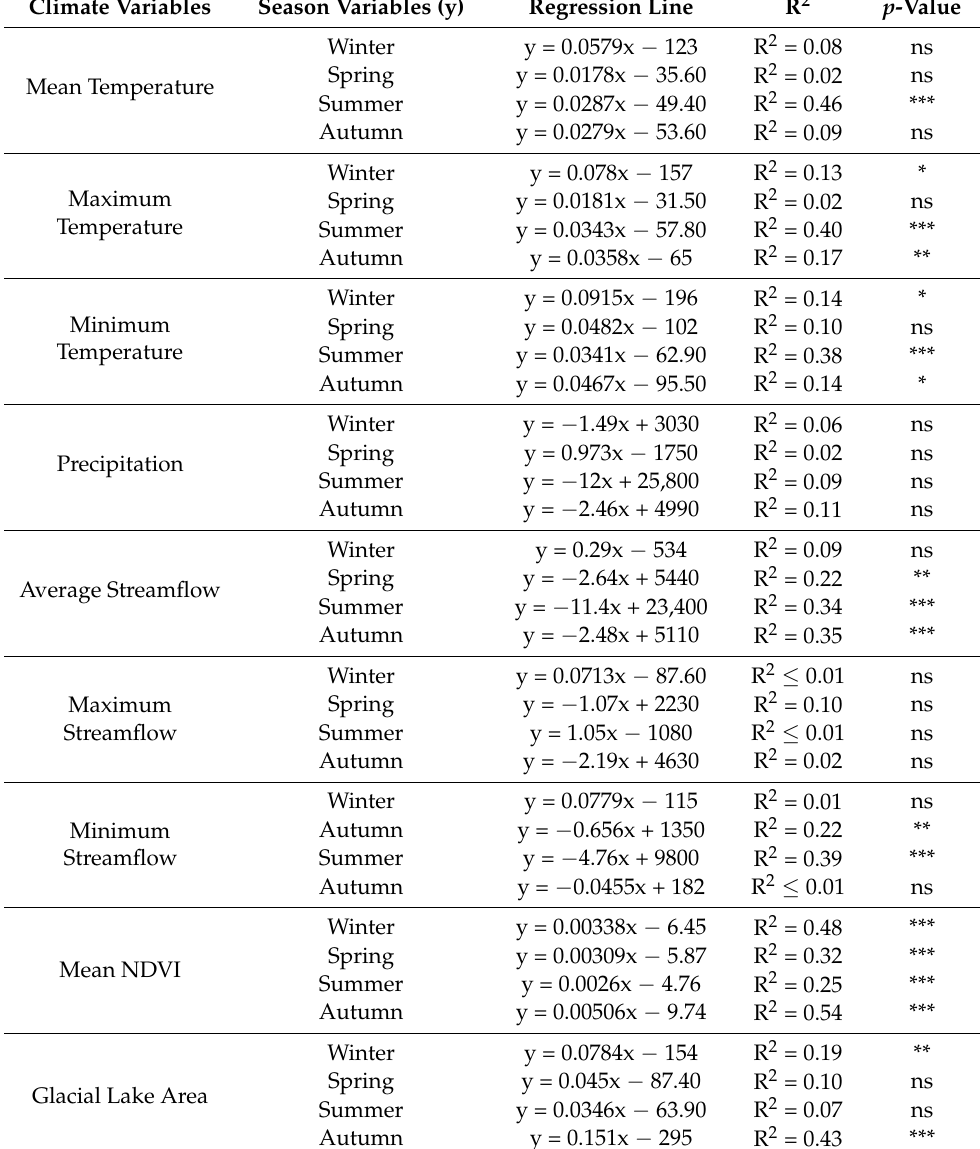
Table 3. Linear regression equations of all seasonal series of temperature, precipitation, streamflow, NDVI, and surface water